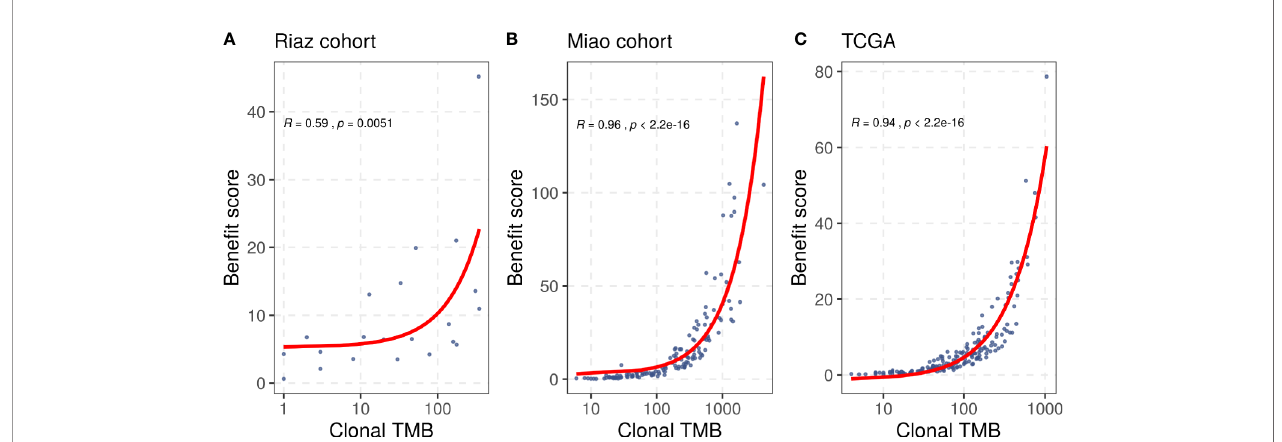
FIGURE 2 | Correlation between the bene fi t score and clonal TMB in (A) the Riaz cohort, (B) the Miao cohort, and (C) the TCGA dataset. Spearman correlation coef fi cients and statistical signi fi cance are labeled at the top left in each